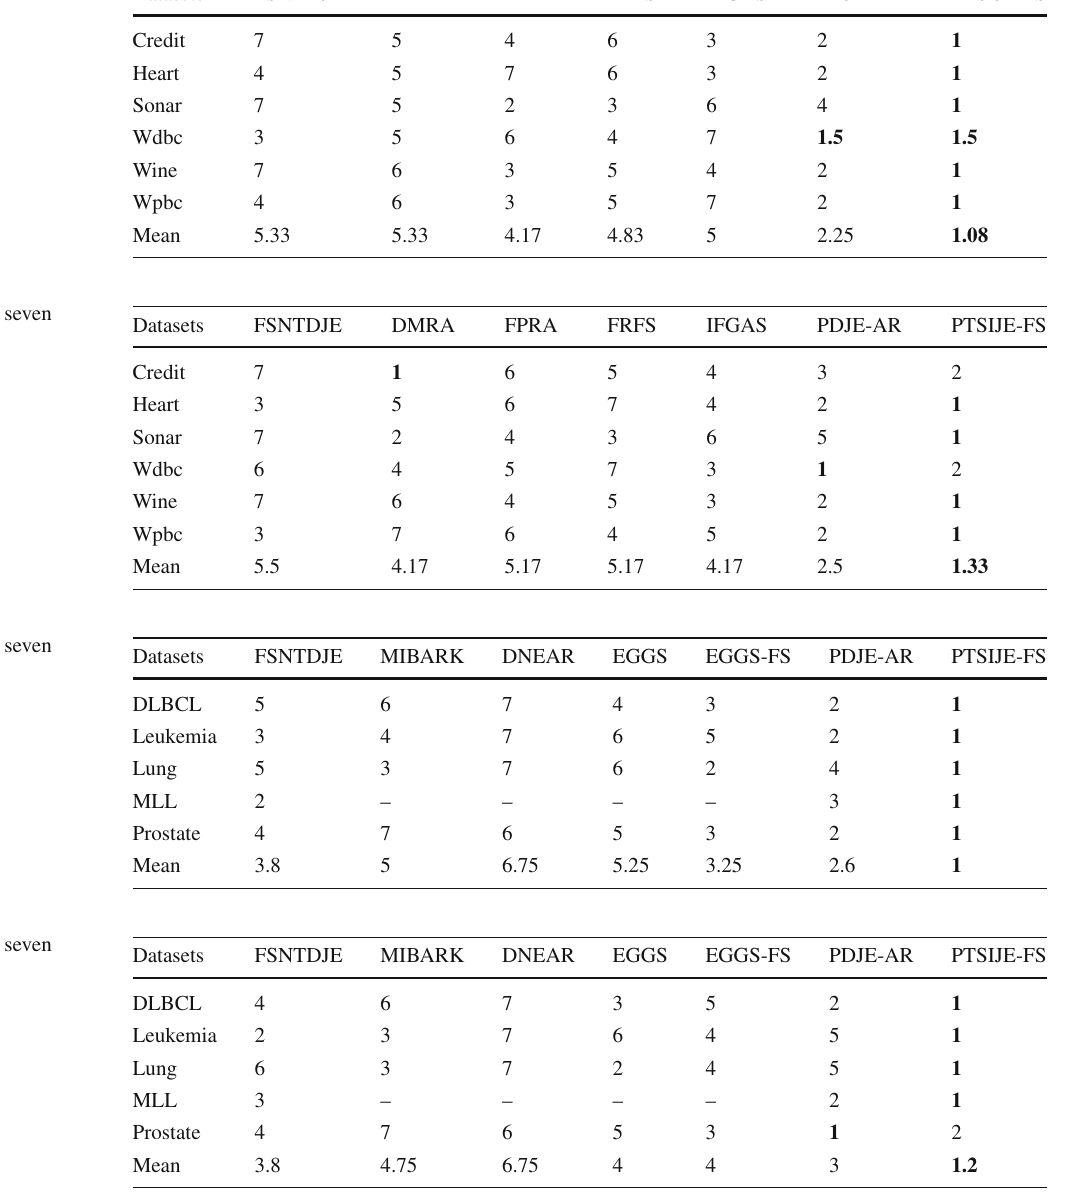
Table 11 Rank of the seven methods with KNN